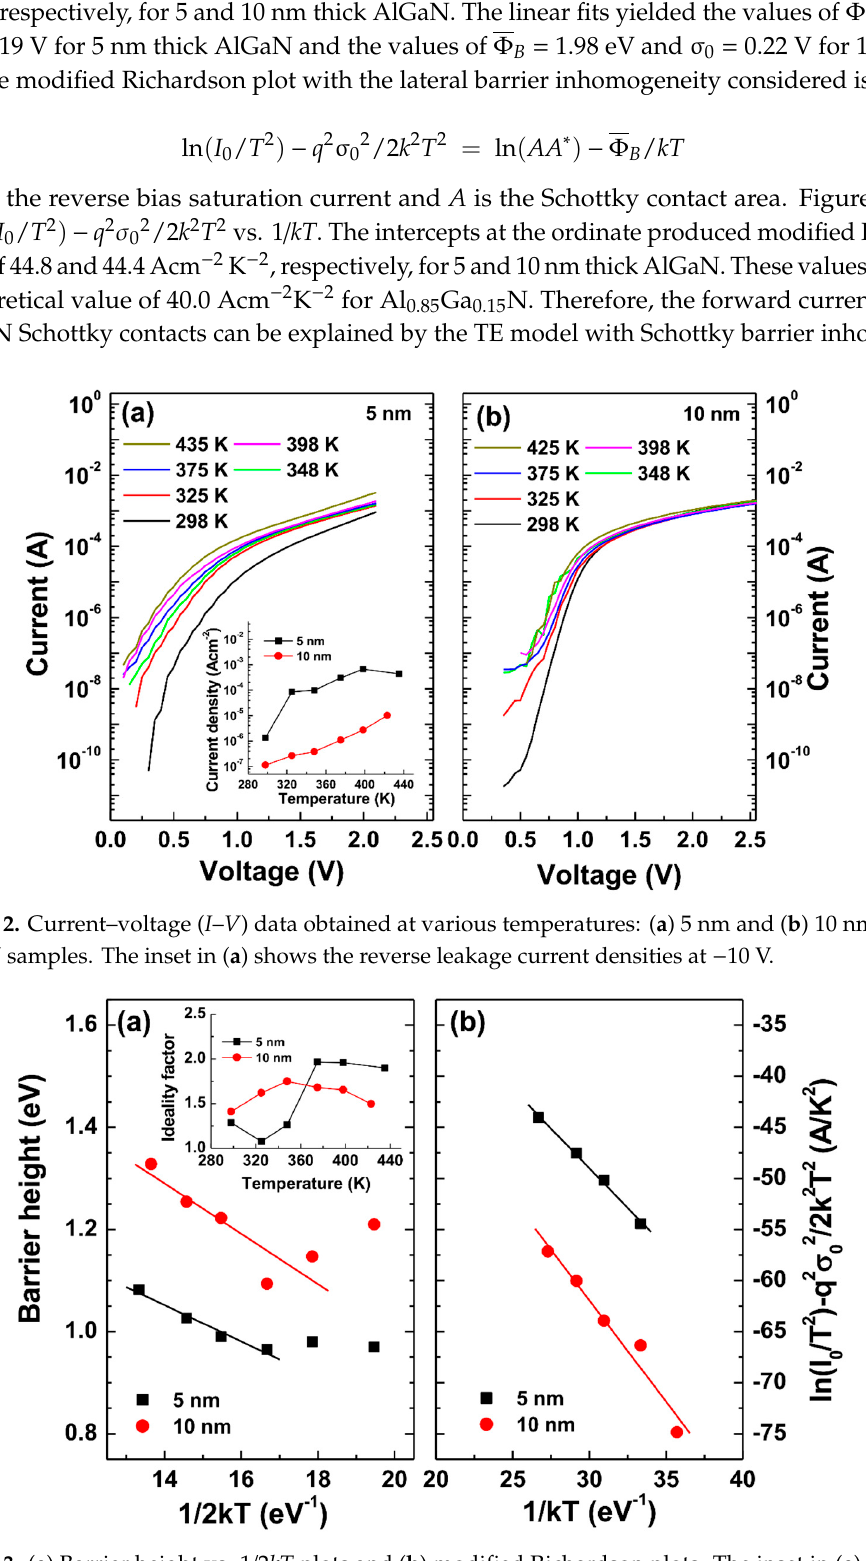
Figure 3. ( a ) Barrier height vs. 1 / 2 kT plots and ( b ) modified Richardson plots. The inset in ( a ) shows the ideality factors.